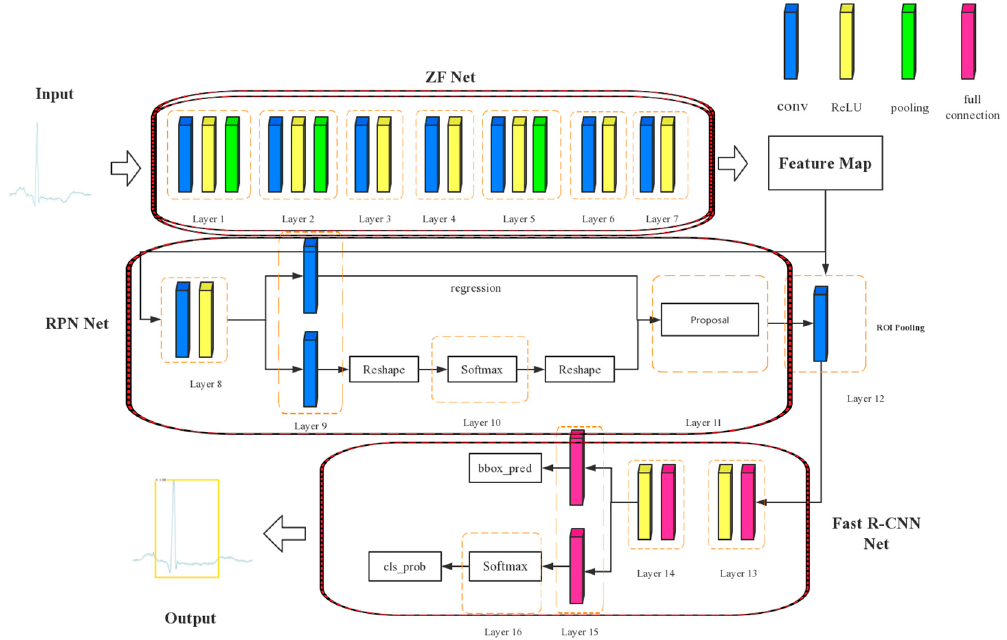
Figure 8. Faster regions with a convolutional neural network (Faster R-CNN) architecture.